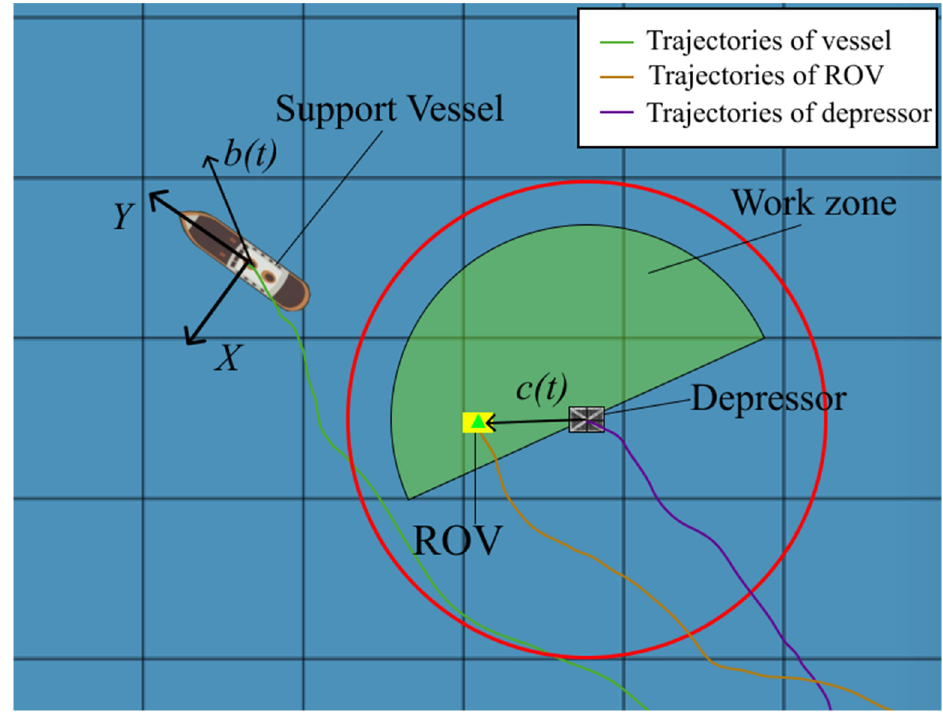
Figure 2. A ROV work